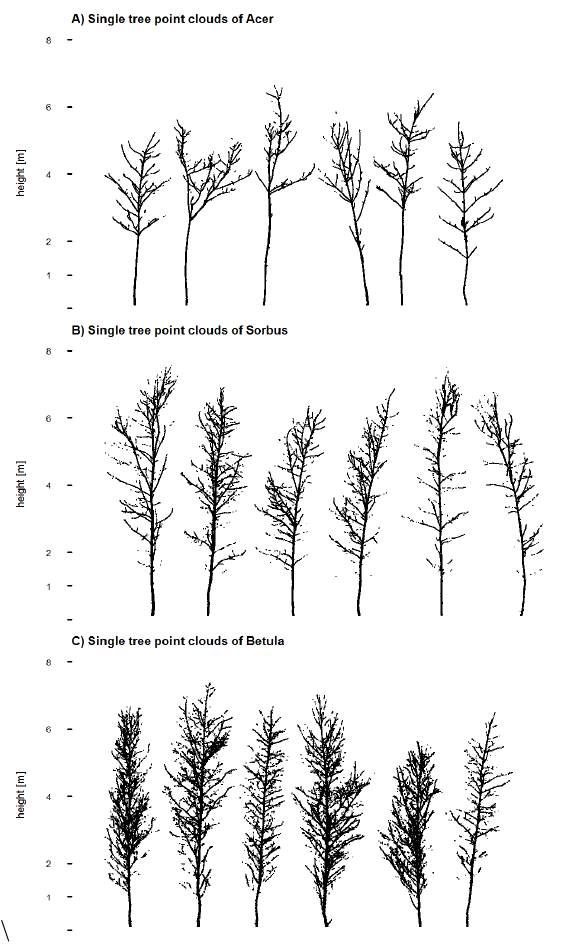
Figure 2. 2D images of all filtered single tree point clouds for ( A ) Acer ; ( B ) Sorbus and ( C ) Betula